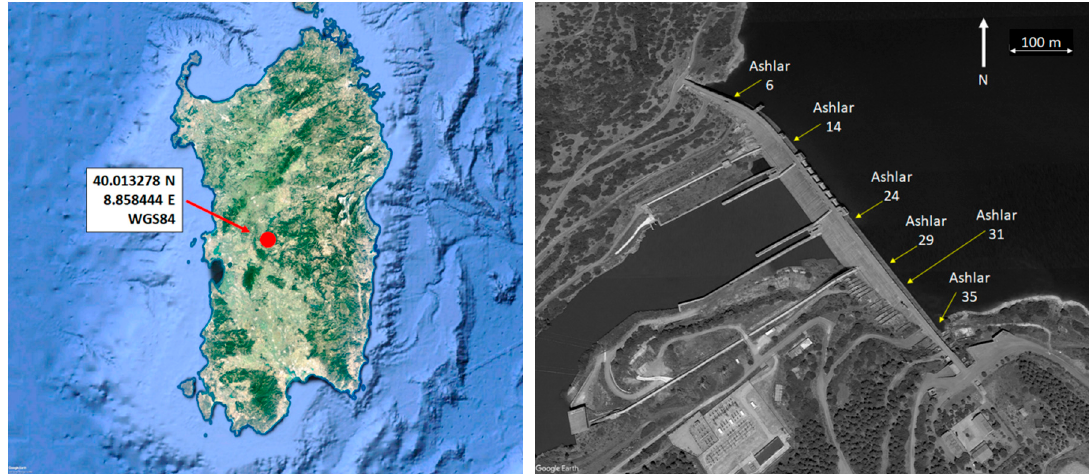
Figure 1. Geographical position of the Cantoniera dam in Sardinia (Italy), on the left : dam aerial view with indicated ashlar positions, on the right (credits Map data ©2015 Google).